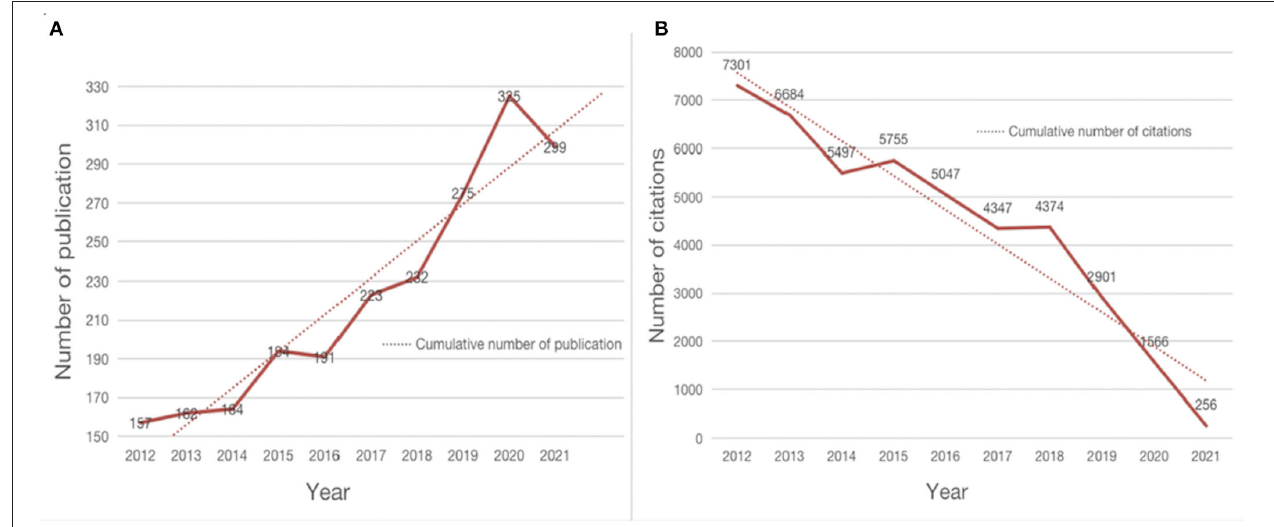
FIGURE 1 | Number of published papers and citations of the exercise on PD research. (A) Annual number of publications and trends in exercise on PD research from 2012 to 2021. (B) Annual number of citations and trends in exercise on PD research from 2012 to 2021.